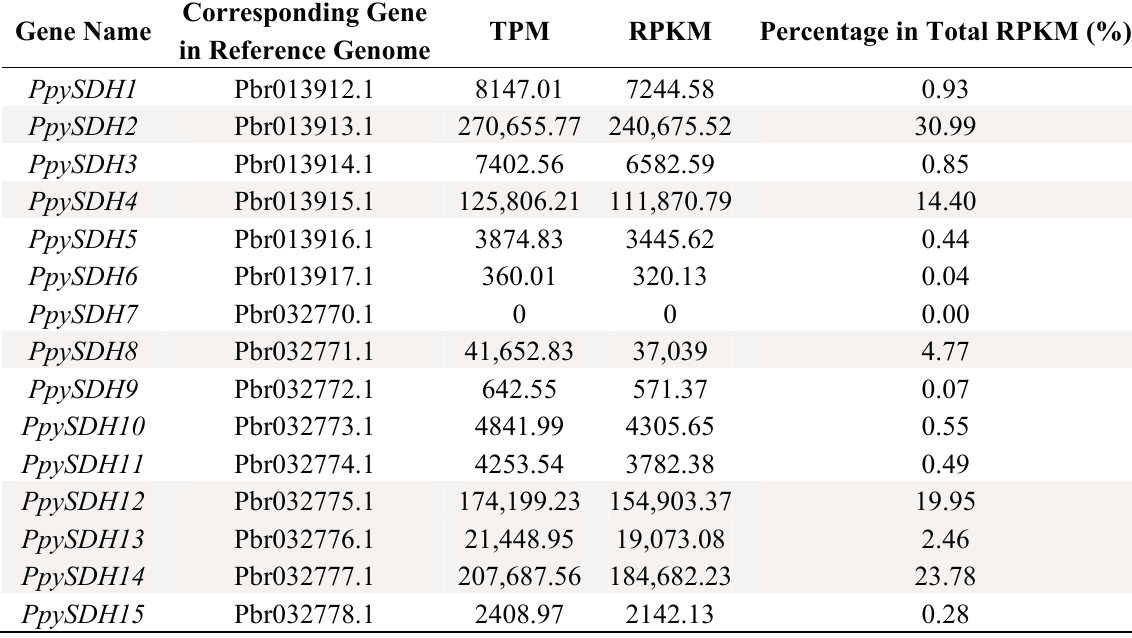
Table 3. Expression of SDH genes in sand pear fruit. Values shown are TPM (transcripts per million) and RPKM (reads per kilo-base per million). Lines marked with grey background denote the top six most strongly-expressed